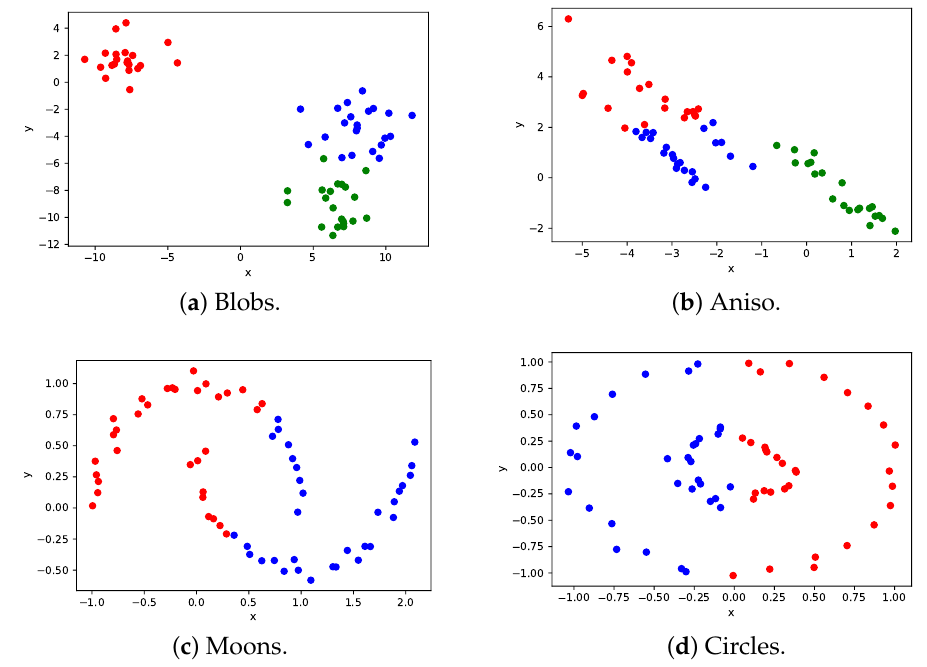
Figure 2. Clustering results of the conventional